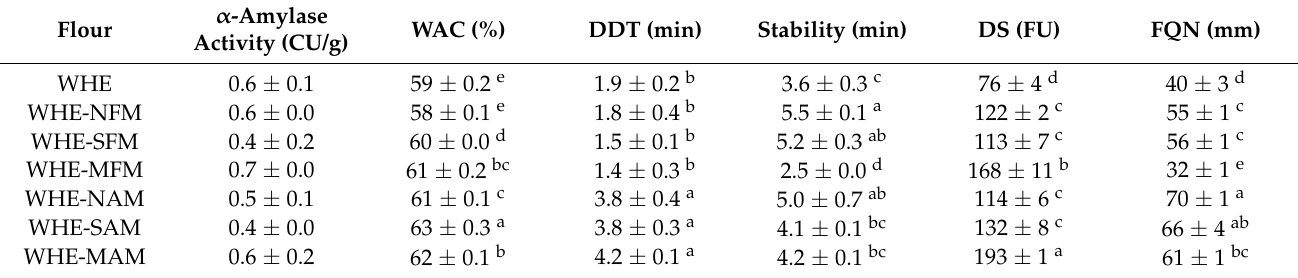
Table 2. Enzyme activity of flours and farinogram properties of